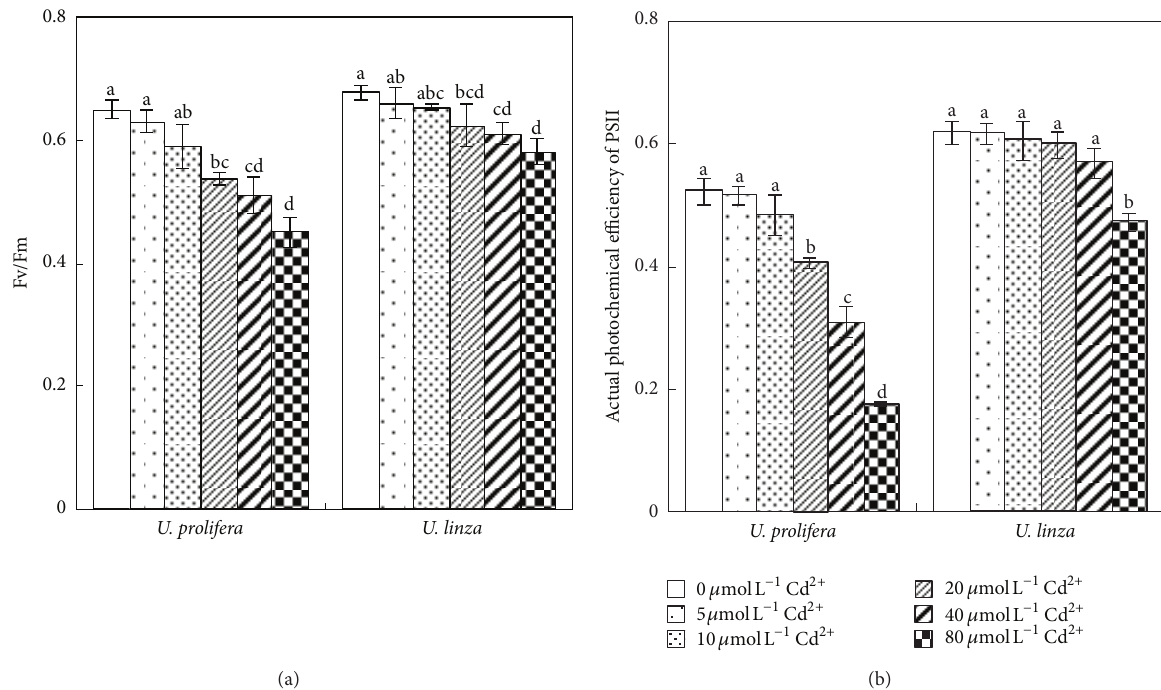
Figure5: Effectsofdifferent concentrations ofCd 2+ (0,5,10,30,40, and80 𝜇 molL −1 )onFv/Fm (a)and Yield(actual photochemical efficiency of PSII) (b) of U. prolifera and U.